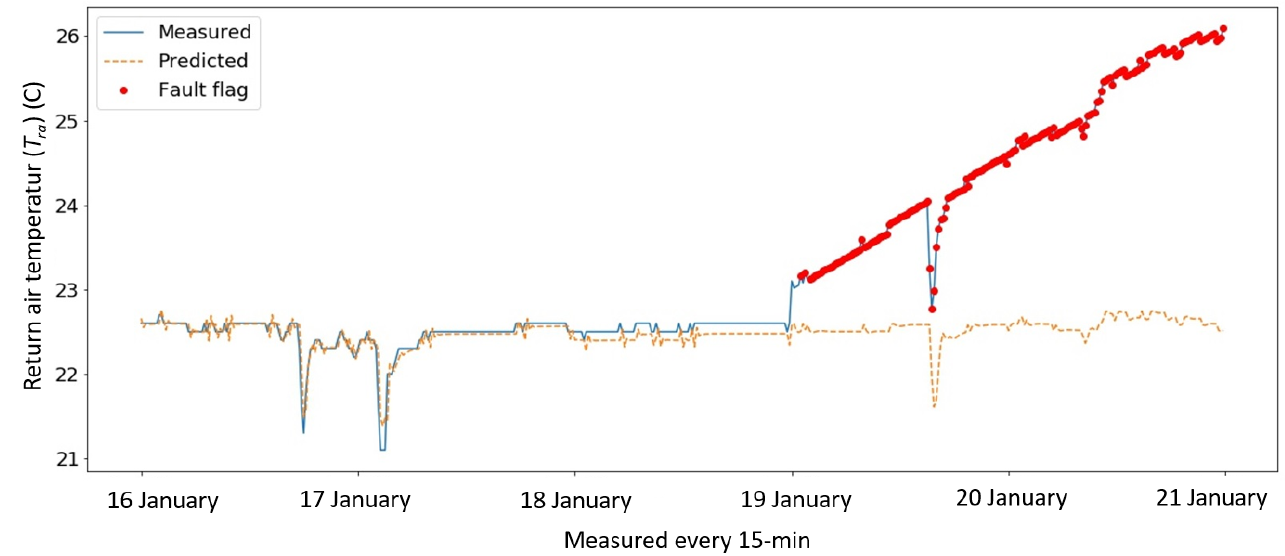
Figure 11 . Measurements and predictions of T ra with artificial faulty data.